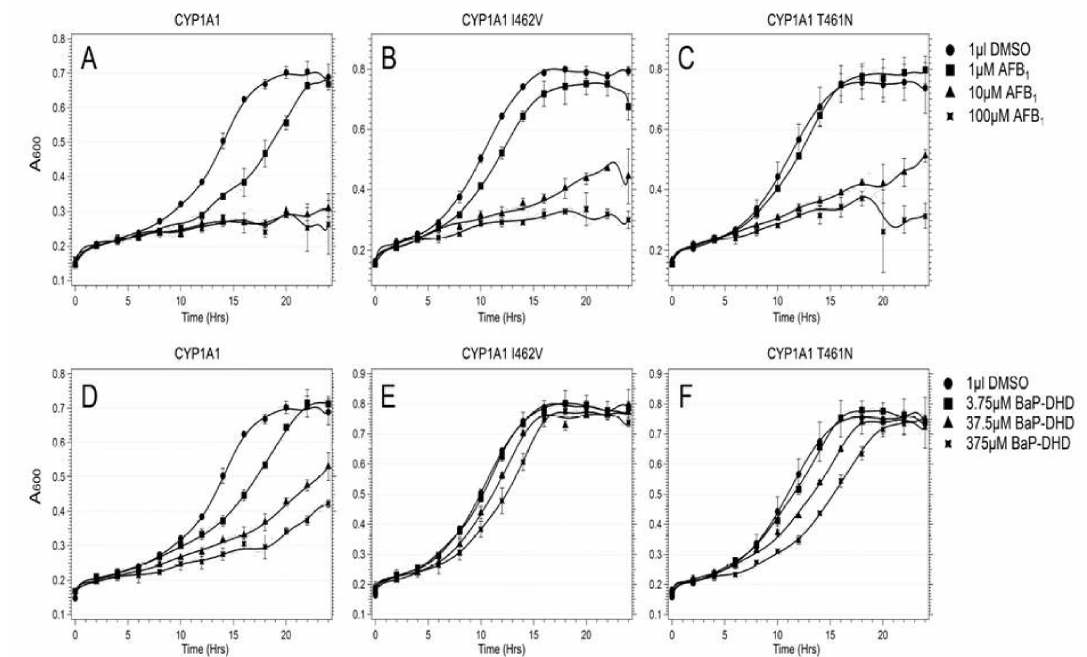
Figure 6. Expression of CYP1A1 alleles in budding yeast activates BaP-DHD and AFB1 to become potent genotoxins. Growth of the rad4 rad51 strain expressing CYP1A1 ( A , D ), CYP1A1 I462V ( B , E ), CYP1A1 T461N ( C , F ) was measured in real-time after exposure to either AFB1 (top) or BaP-DHD (bottom). A 600 is plotted against time